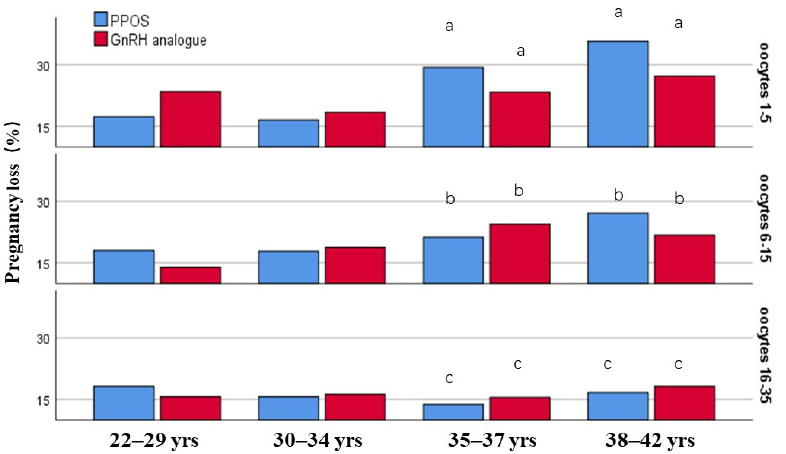
Figure 2. The incidence of pregnancy loss was stratified by maternal age and the retrieved oocytes. Different letter means significant difference among the subgroups of different oocyte yields ( p <